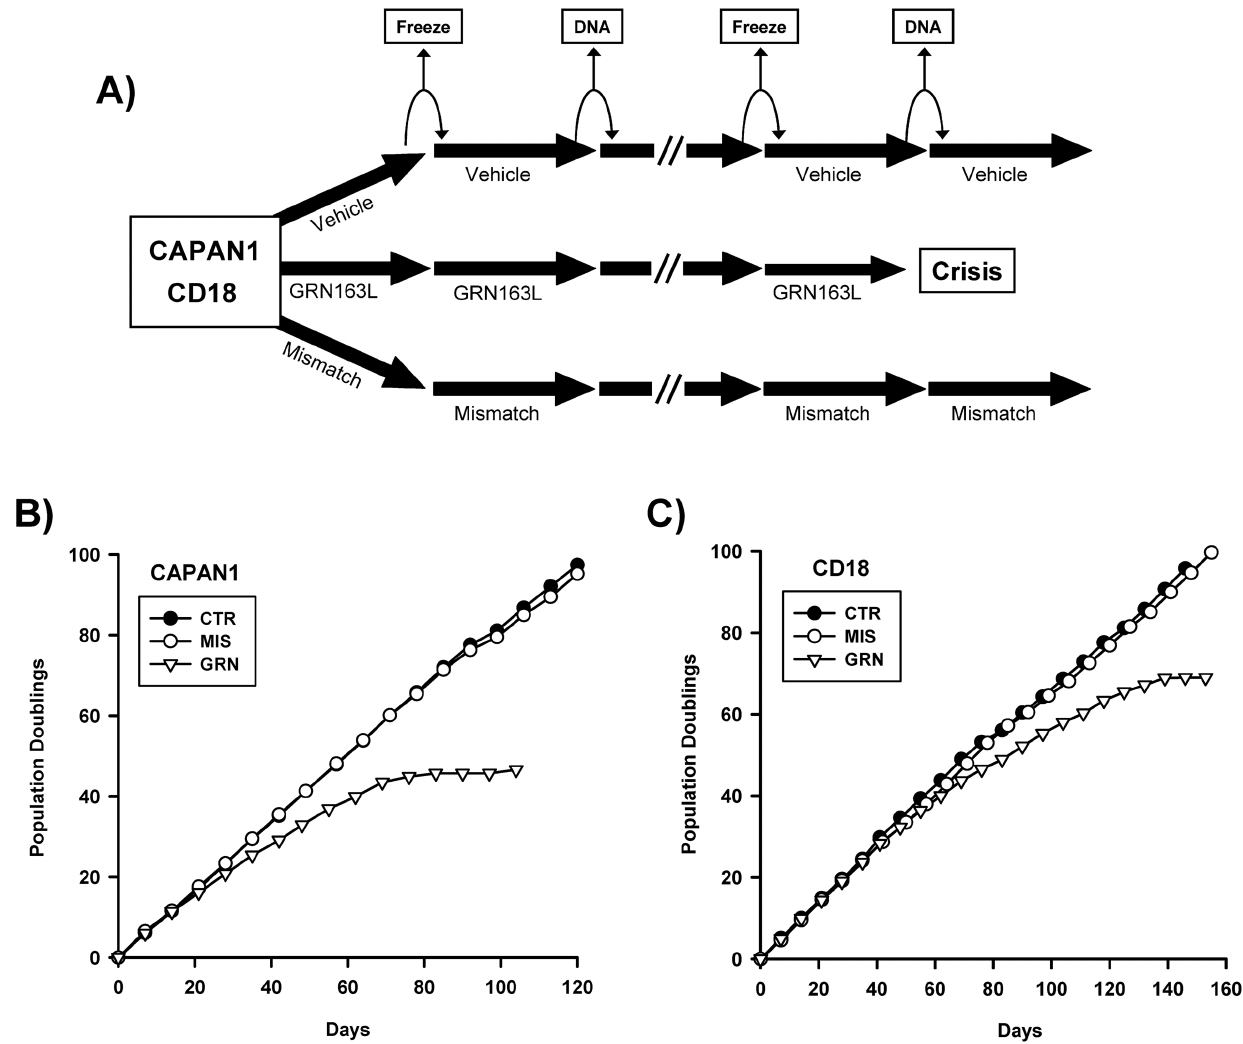
Figure 3. Effects of chronic GRN163L on cellular lifespan. A) Pancreatic cancer cell lines CAPAN1 and CD18 were selected for these studies. Every 2–3 days, each lines was given either no drug (vehicle), GRN163L (1 m M) or the Mismatched oligo (1 m M). Once a week, cells were counted and the results are plotted as the number of population doublings achieved as a function of time. Every other week, samples were put aside for TRF analysis (DNA) or frozen down as backup. B,C) Growth curves of the drug-treated CAPAN1 (B) and CD18 (C) cells are shown.